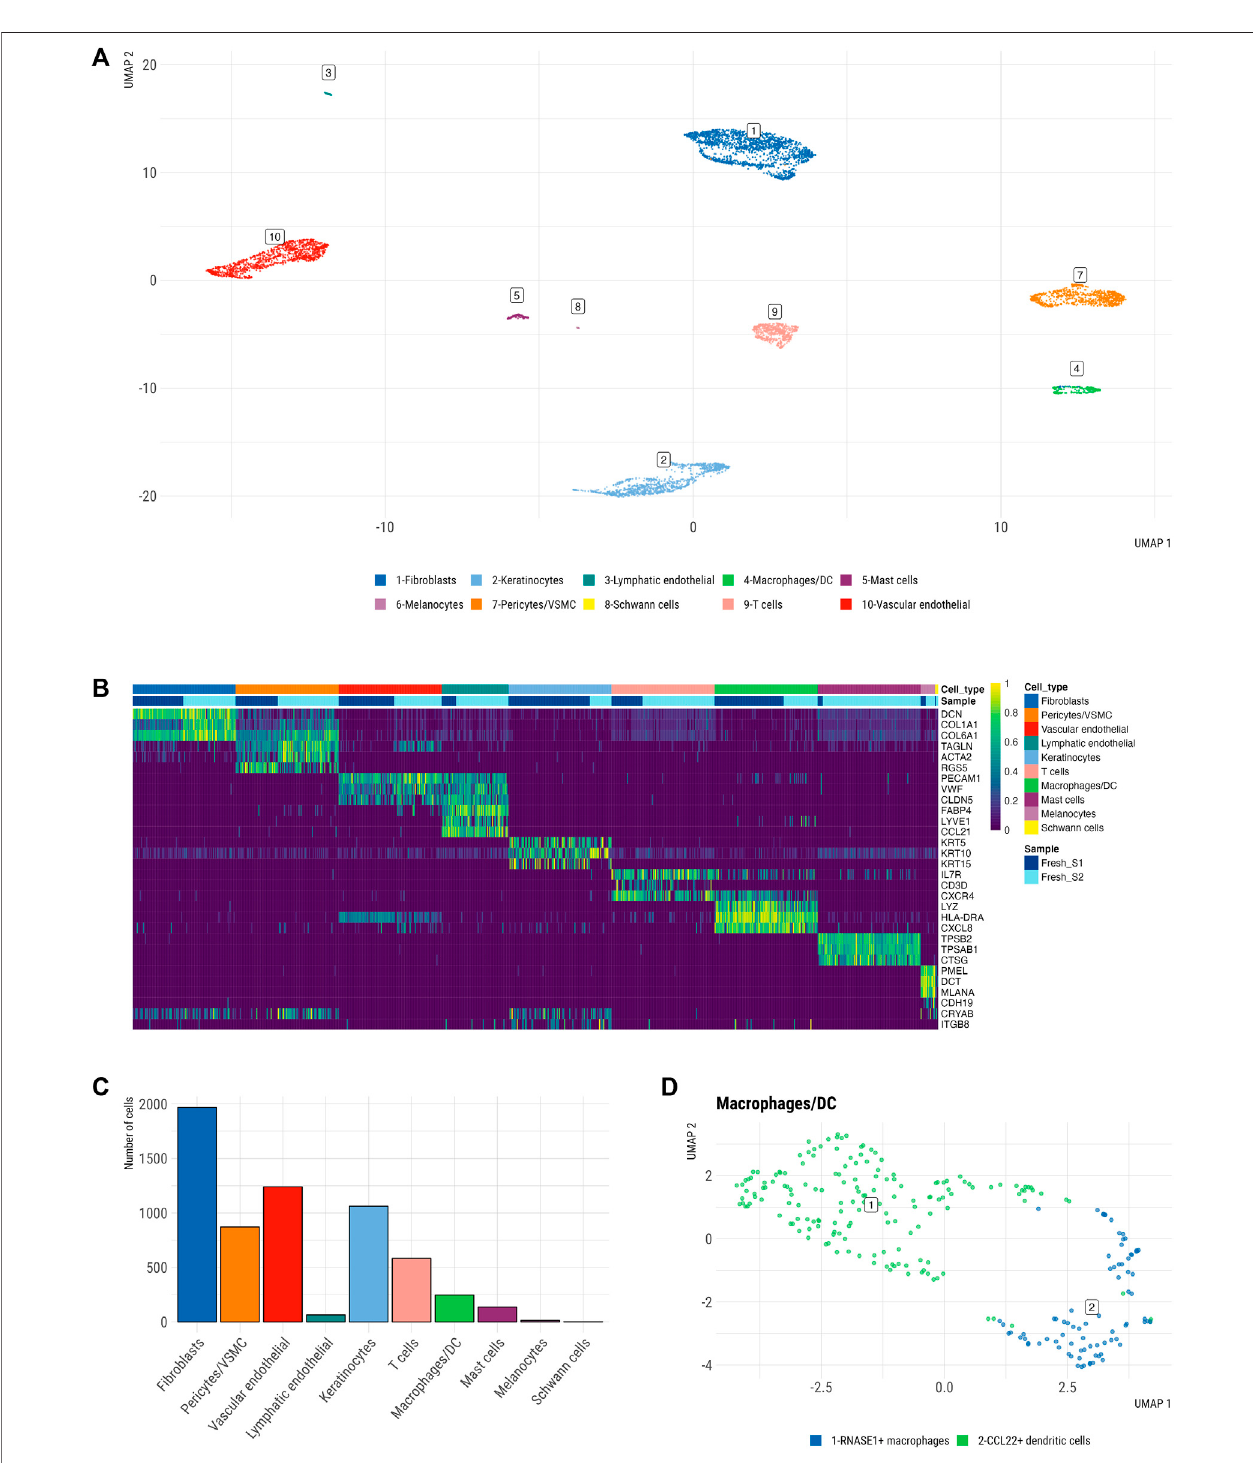
FIGURE2| Single cell atlas offreshly dissociated human skin. (A) Uniformmanifoldapproximationand projection(UMAP) plot depicting single-cell transcriptomes from whole human skin ( n = 2), coloured by cell type. Each dot represents a single cell ( n = 6,192). Color-code de fi ned by manual cluster annotation after unsupervised clustering was performed via Walktrap clustering (see Methods ). Shown are 10 principal skin cell populations including fi broblasts, keratinocytes, lymphatic endothelial cells, macrophages/DC, mast cells, melanocytes, pericytes/VSMCs, Schwann cells, T cells, vascular endothelial. (B) Heatmap showing the three marker genes of each cell cluster. Each column represents a single cell, each row represents an individual gene. A maximum of a hundred cells were sampled per cell cluster. Magnitude of gene expression measured in scaled log normalized UMI counts. Yellow indicates maximum gene expression and purple indicates no expression of the gene. (C) Relative abundance of main cell types across integrated fresh skin samples. (D) Macrophage/DC cluster containing a larger population of 165 DCs and a smaller population of 82 macrophages.